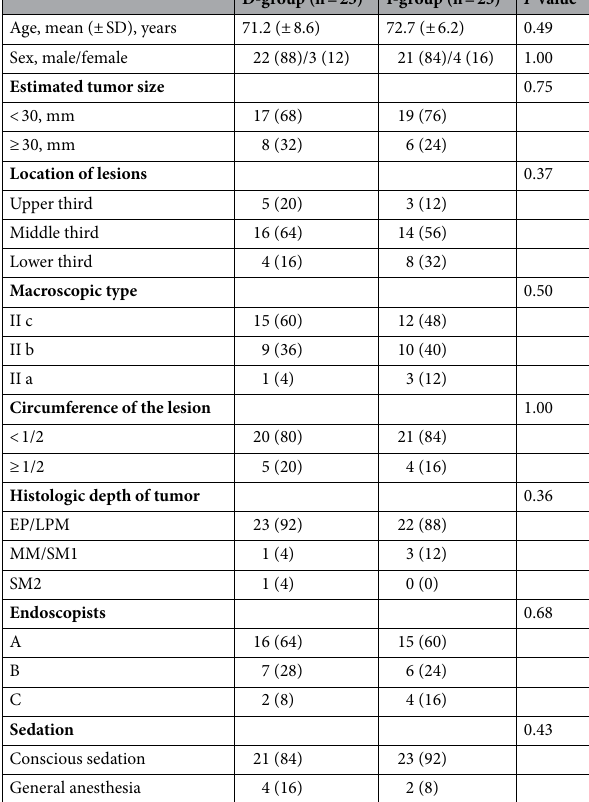
Table 1. Baseline characteristics of between the D-group and the I-group. Values are n (%) unless otherwise indicated. D-group DualKnife group, I-group ITknife nano group, SD standard deviation, EP carcinoma in situ, LPM tumor invasion into the lamina propria mucosa, MM tumor invasion into the muscularis mucosa, SM1 tumor invasion into the upper third of the submucosal layer, SM2 tumor invasion into the middle third of the submucosal